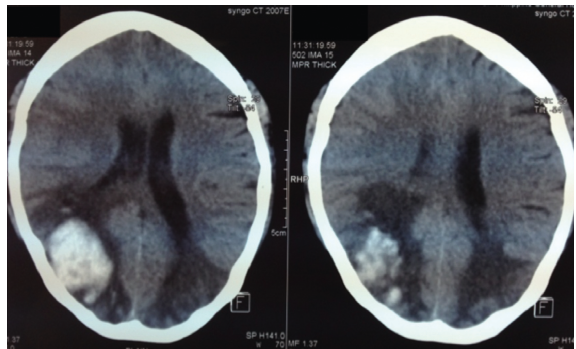
Figure 2: Plain cranial CT demonstrating a decrease in previously noted cerebral edema and midline